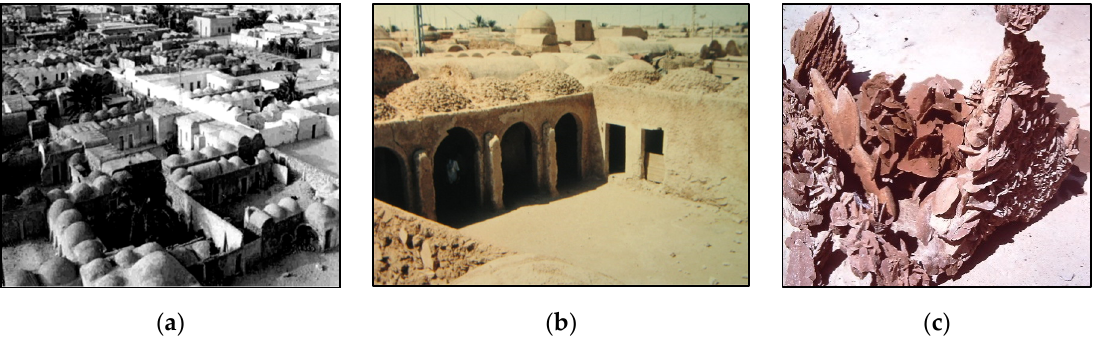
Figure 5. Traditional quarter (Ksar) in El ‐ Oued Souf, Algeria. ( a ) Settlement layout (photo: M. Sherzad); ( b ) courtyard house (photo: M. Sherzad); ( c ) sand stone (photo: M. Sherzad).